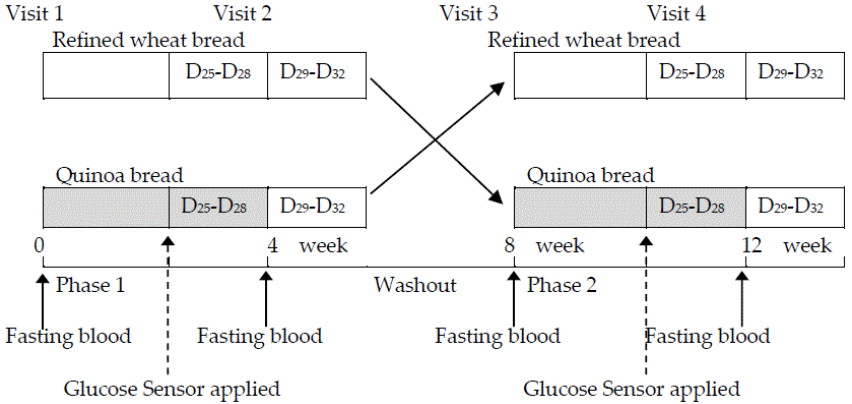
Figure 2. Intervention study design. Randomized controlled crossover study in which subjects received either refined wheat bread or quinoa bread for a period of 4 weeks. Anthropometric and blood pressure measurements were performed and fasting blood samples collected from each volunteer before and after each intervention period as indicated. D 25 –D 28 last four days of each intervention period; D 29 –D 32 first four days of the washout period.